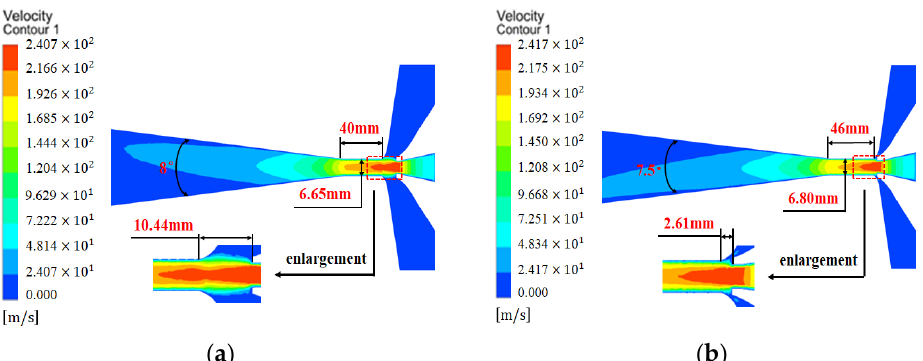
Figure 14. Velocity cloud diagram of the new jet pump before and after optimization. ( a ) Before optimization. ( b ) After optimization. optimization. ( b ) After